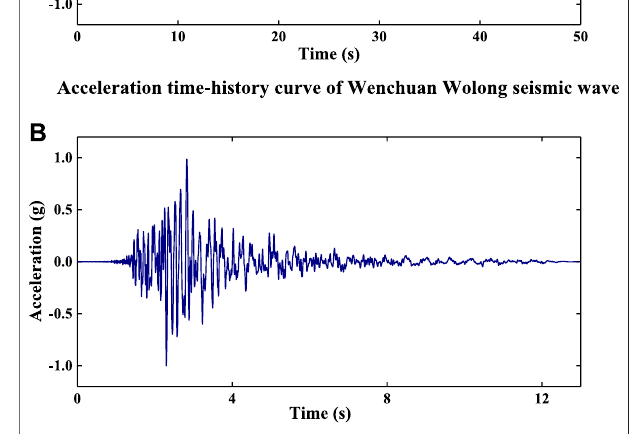
Figure 5 . The shaking table test started with an amplitude of 0.1 g, and the amplitude of each seismic wave (0.1 – 1.2 g) was gradually increased in the order of the Wenchuan Wolong seismic wave, Kobe seismic wave, and EL Centro seismic wave until the model failed. Before each peak seismic wave loading, the model was swept by white noise with an amplitude of 0.05 g. The speci fi c loading conditions are shown in Table 2 .